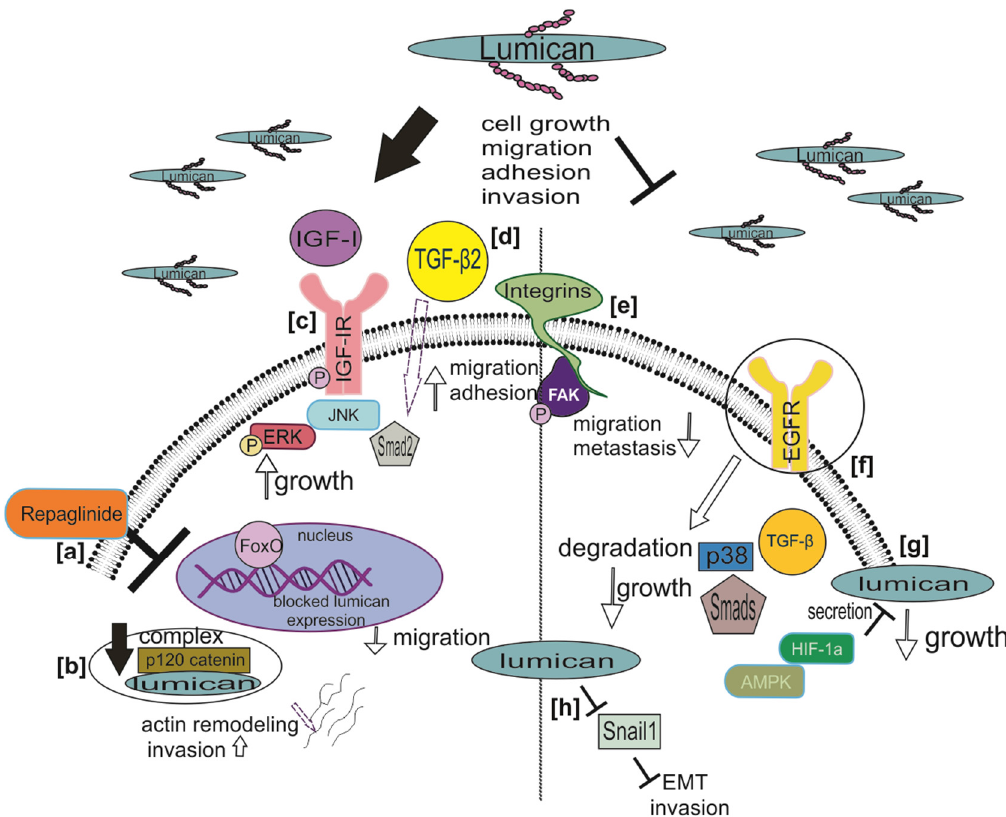
Figure 1. Schematic representation of lumican’s signaling in carcinogenesis. ( a ) Inhibiting the binding of FOXO3 to the lumican promoter by the small molecular weight leads to decreased FOXO3-dependent lumican expression and neuroblastoma cell migration. ( b ) Upon lumican downregulation, its colocalization with p120 catenin (p120ctn) decreases, leading to actin cytoskeleton remodeling and accelerated lung cancer cell invasion. ( c ) Lumican-deficient hepatic cancer cells show decreased invasion and migration mediated by reducing IGF-IR, ERK-1, and JNK activation status. ( d ) Lumican is an upstream regulator of the TGF- β 2/Smad 2 signaling pathway in an osteosarcoma cell model, regulating cell adhesion. ( e ) Lumican interacts with the integrin β 1/FAK signaling axis, affecting tumor progression positively or negatively. ( f ) Lumican induces the dimerization of the EGFR receptors and their subsequent uptake and degradation, leading to attenuated PDAC cell growth. ( g ) Hypoxia significantly reduces lumican secretion from pancreatic stellate cells and results in attenuated PDAC cell growth. ( h ) Lumican affects the signaling of Snail, an EMT trigger molecule that facilitates cancer metastasis, attenuating melanoma metastasis to the